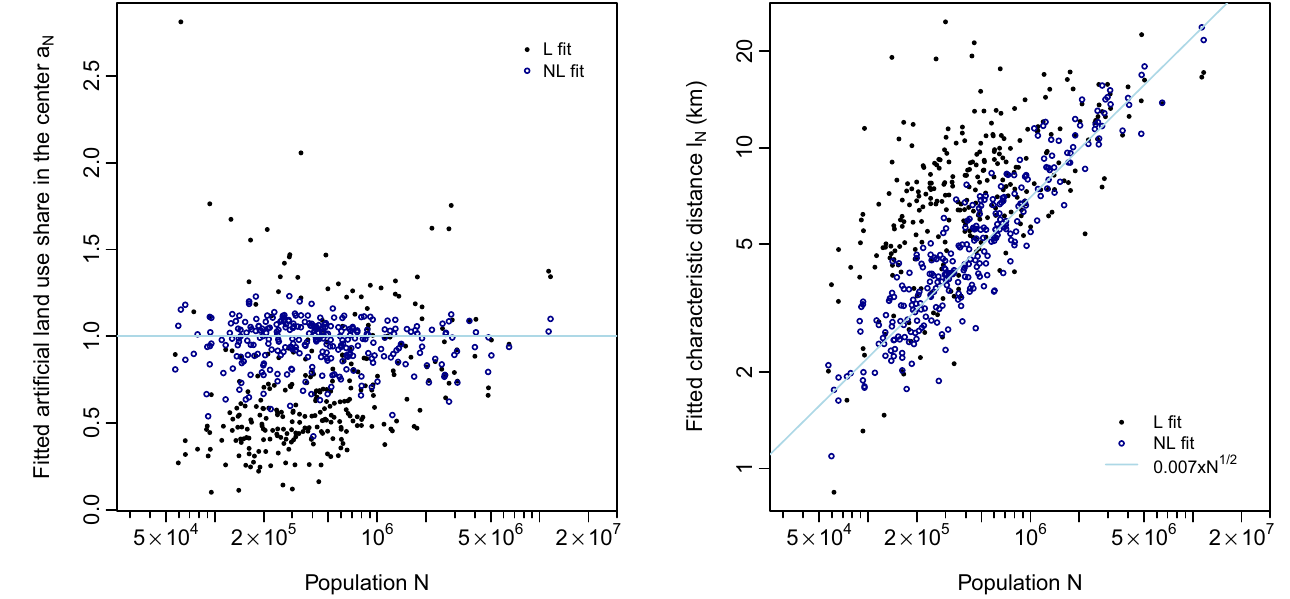
Figure 1. Estimated parameters of the exponential fits of artificial land use profiles, displayed as functions of the total population N . Predicted share a N of artificial land in the center (left) and characteristic decrease distance l N (right), for both linear and non-linear fits. The straight lines give our expectations 4 : a N = 100 % on the left (whatever the total population), and a scaling with the square root of total population